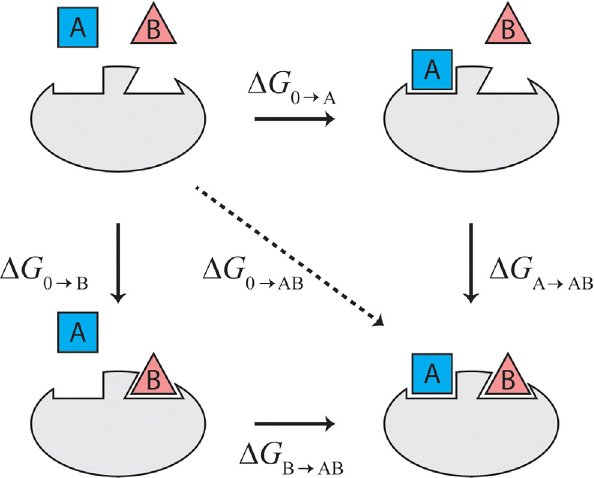
Fig 1. Bidirectional symmetry in allosteric systems. Suppose that a protein can bind two different ligands, A and B, each at their respective sites. The difference in free energy Δ G 0 ! AB between a state with both ligands bound and one with neither ligand bound is independent of the order in which the ligands bind, so we can write it both as Δ G 0 ! AB = Δ G 0 ! B + Δ G B ! AB and as Δ G 0 ! AB = Δ G 0 ! A + Δ G A ! AB , implying that Δ G 0 ! B + Δ G Δ G Δ G − Δ G Δ G − Δ G Δ G B ! AB = 0 ! A + A ! AB . Rearranging this equation yields A ! AB 0 ! B = B ! AB 0 ! A . That is, the difference in the binding energy of ligand A with or without ligand B bound is the same as the difference in the binding energy of ligand B with or without ligand A bound. If one side of this equation is negative, the other must also be negative, and if one side is positive, the other must also be positive. Thus, if binding of ligand B is more favorable in the presence of A, then binding of ligand A is more favorable in the presence of ligand B (positive cooperativity). Likewise, if the presence of ligand A disfavors the binding of ligand B, then the presence of ligand B disfavors the binding of ligand A (negative